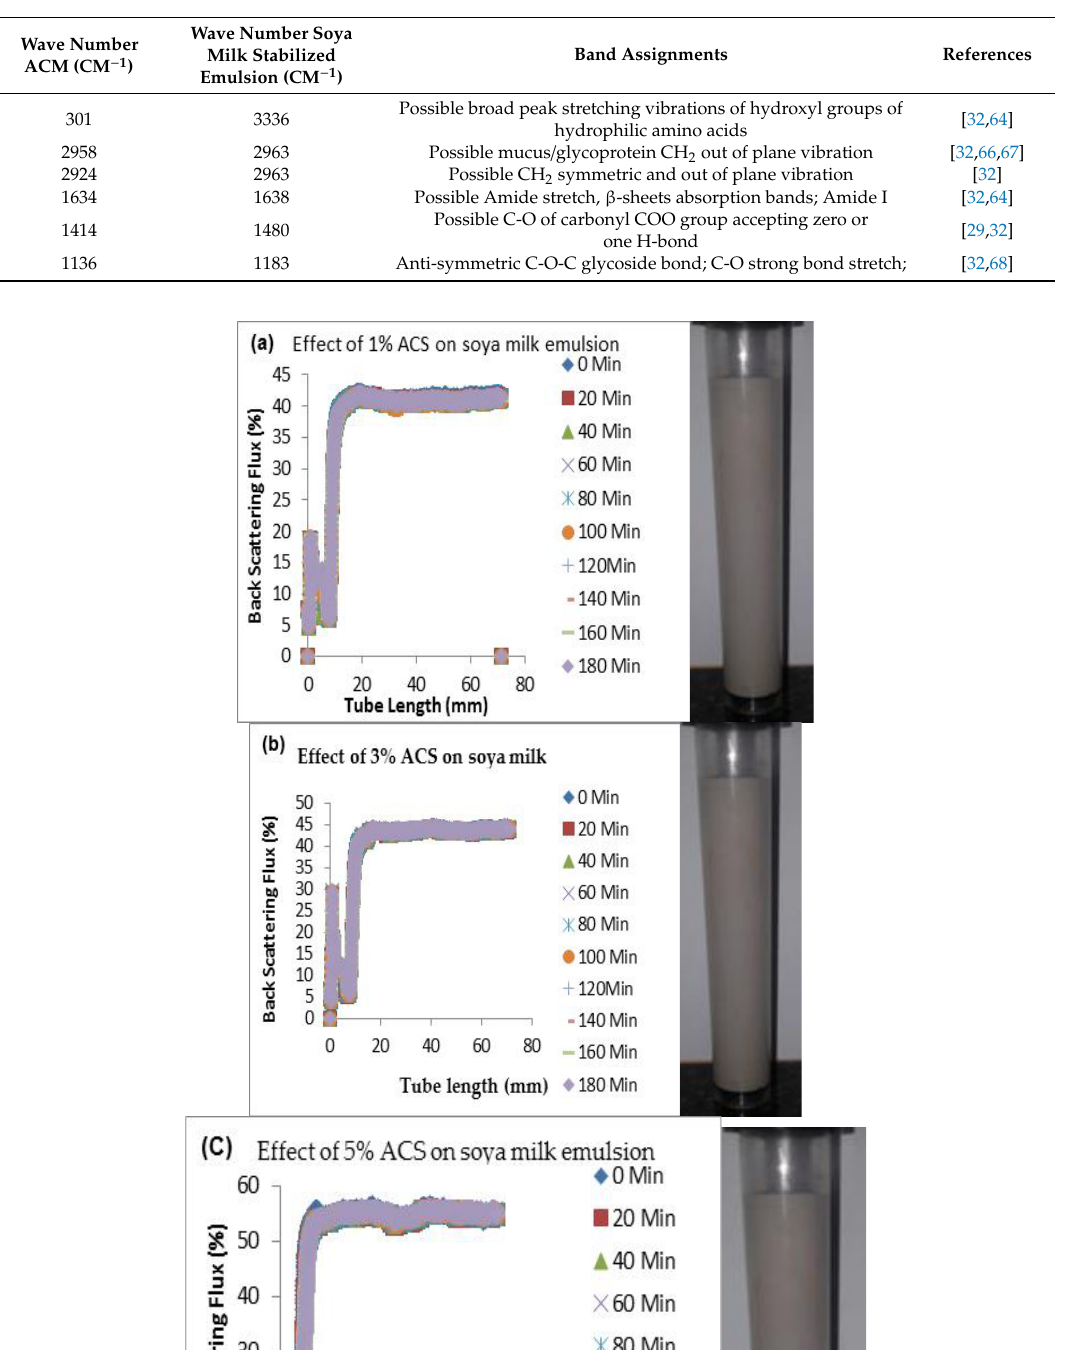
Table 2. Interactions observed in the functional groups ACM-stabilized soya milk emulsion.